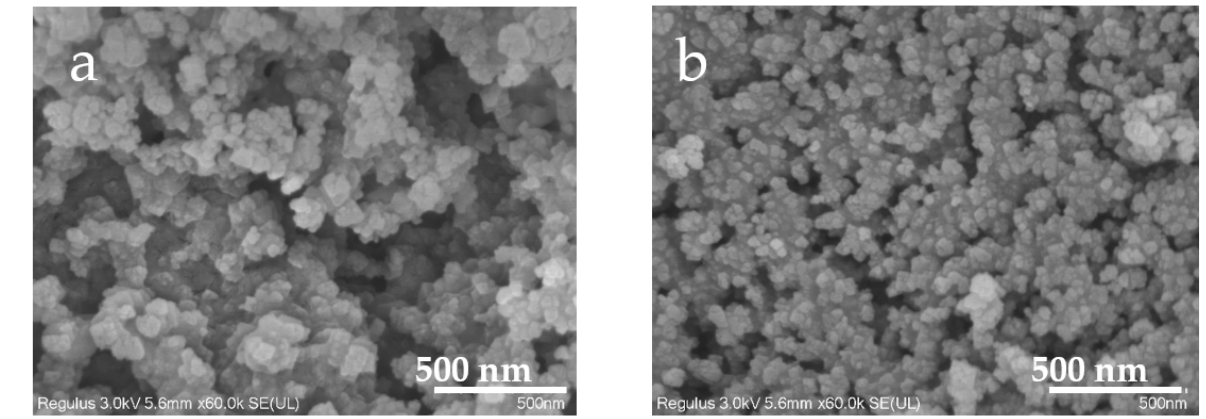
Figure 6. The SEM images of Ti − Beta ( a ) and Re − Ti − Beta − 0.20 ( b ).